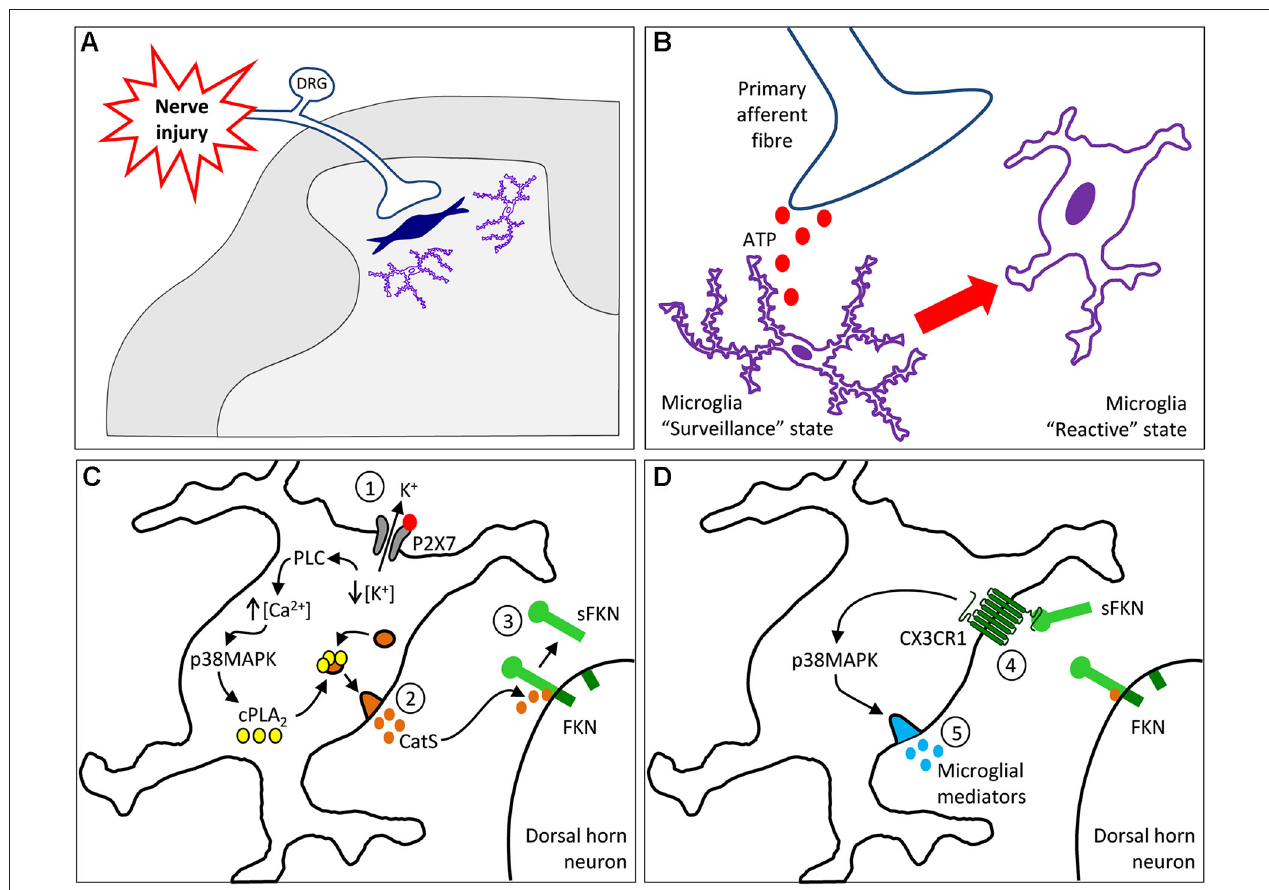
intracellular calcium and phosphorylation of p38 MAPK. P38 phosphorylation then allows phospholipase A 2 (PLA 2 ) mediated translocation of CatS containing lysosomes to the cell membrane, whereby exocytosis releases CatS into the extracellular space (2). Extracellular CatS is then able to cleave membrane bound FKN from dorsal horn neurons, liberating soluble FKN (sFKN) (3). (D) sFKN feeds back onto the microglial cells via the CX3CR1 receptor (4) to further activate the p38 MAPK pathway and release inflammatory mediators, (5) that activate neurons and result in chronic pain. Abbreviations: DRG, dorsal root ganglia, cPLA 2 , cytosolic PLA 2